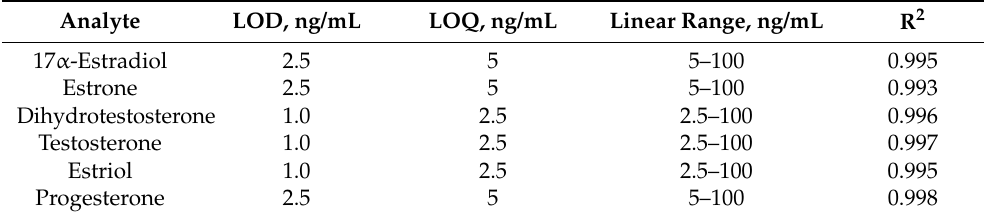
Table 4. Analytical figures of merit of the proposed